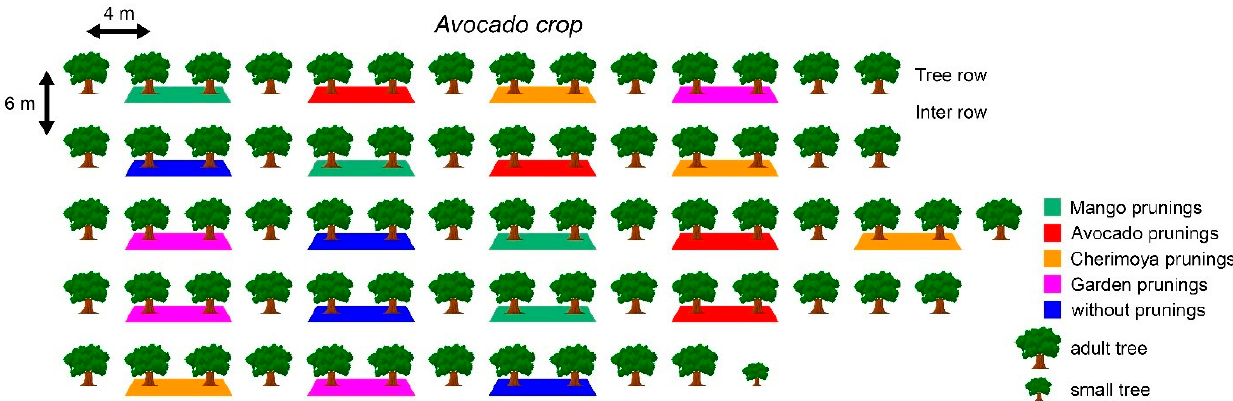
Figure 2. Distribution scheme of the pruning and garden waste in the avocado crop.